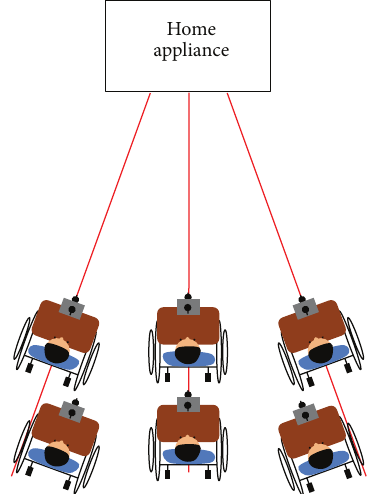
Figure 15: Top view of a sample experimental setup.